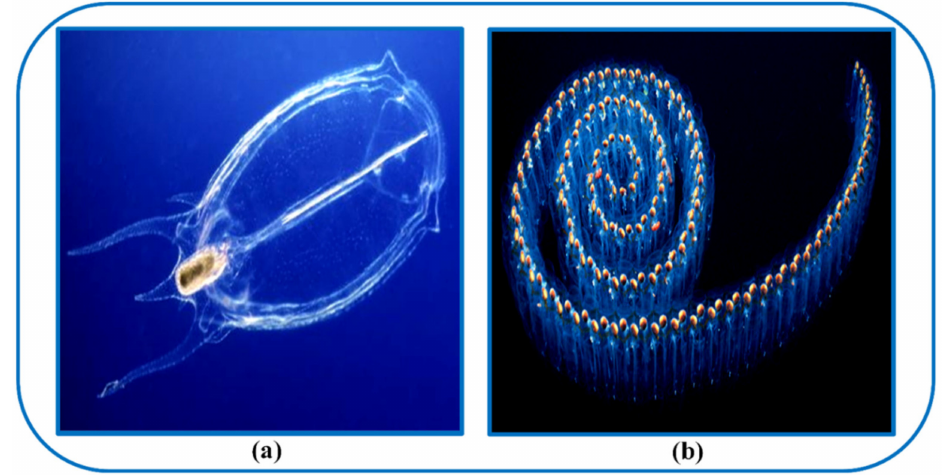
Figure 14. ( a ) Salp, ( b ) salp swarm